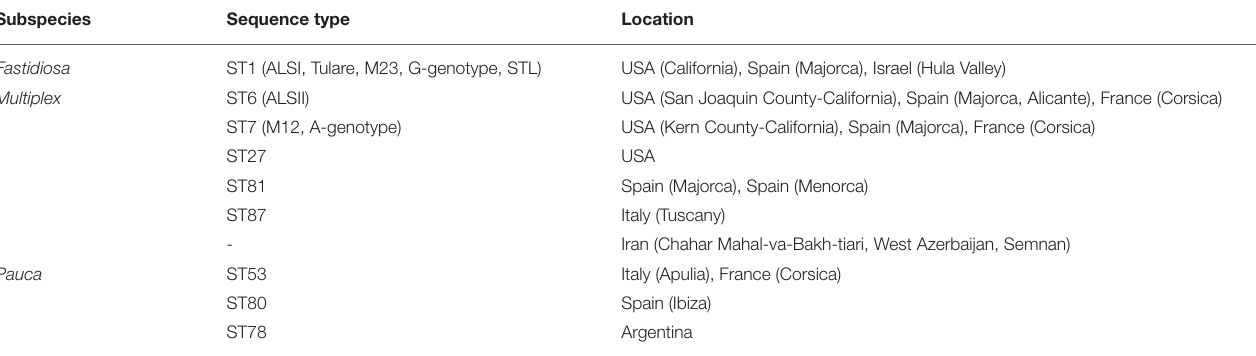
TABLE 1 | Sequence types found in almond trees ( P. dulcis ) and location (Jeger et al., 2018; Amanifar et al., 2019; Bahar et al., 2019; EPPO, 2019; Saponari et al., 2019; EFSA, 2020; www.pubmlst.org). Subspecies Sequence type